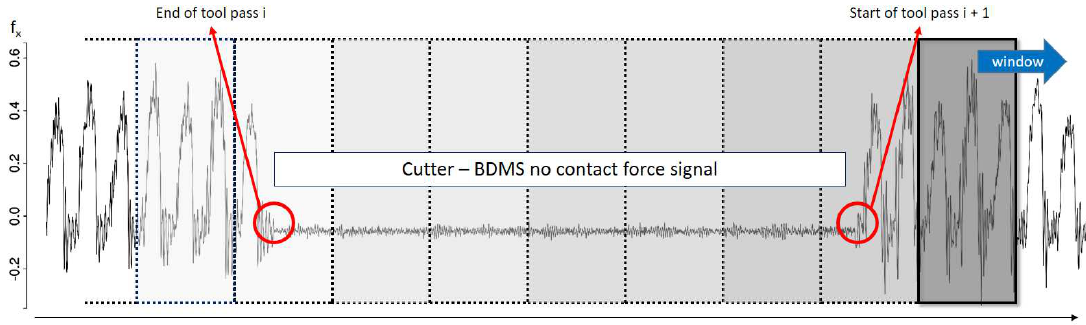
Figure 5. Detection for the removal of the no contact force signal between the cutter and the bright drawn mild steel (BDMS) workpiece. A fixed size window moves along the acquired signal searching for the start and end of a small subsequence of very small values denoting the end of tool pass i and start of tool pass i +